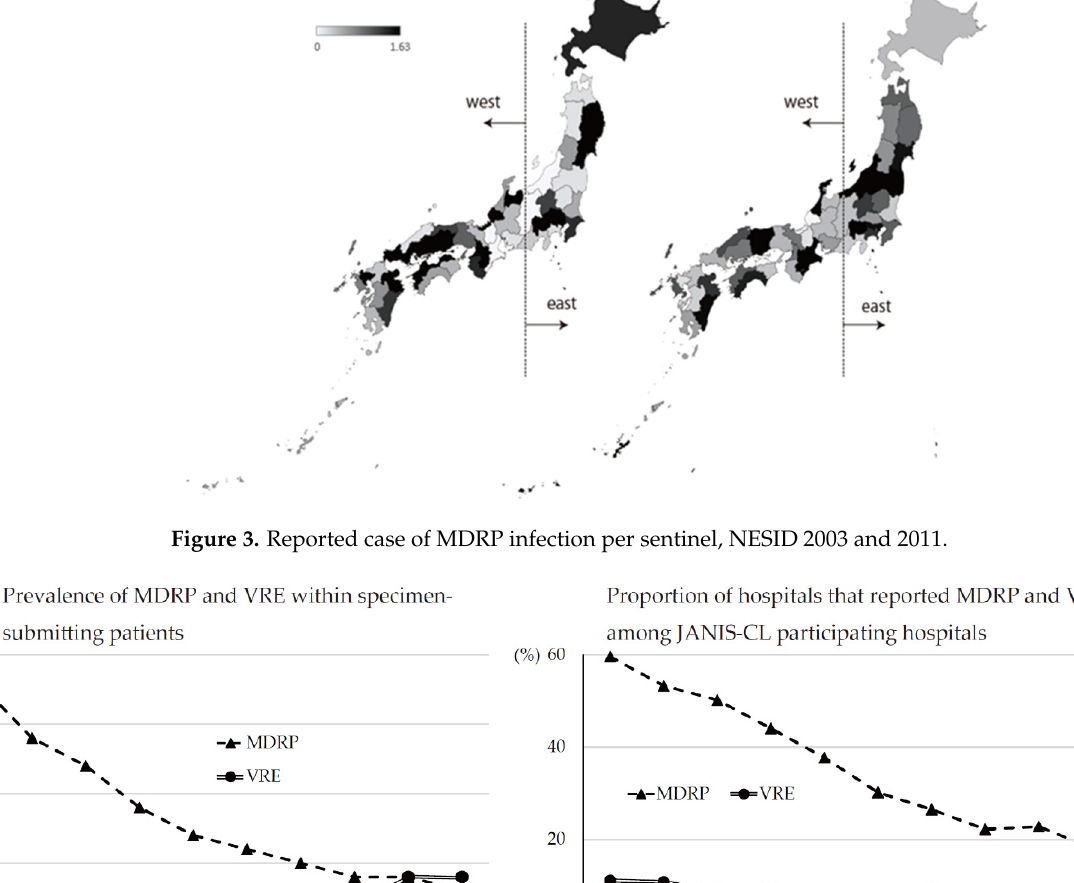
Figure 3. Reported case of MDRP infection per sentinel, NESID 2003 and 2011.